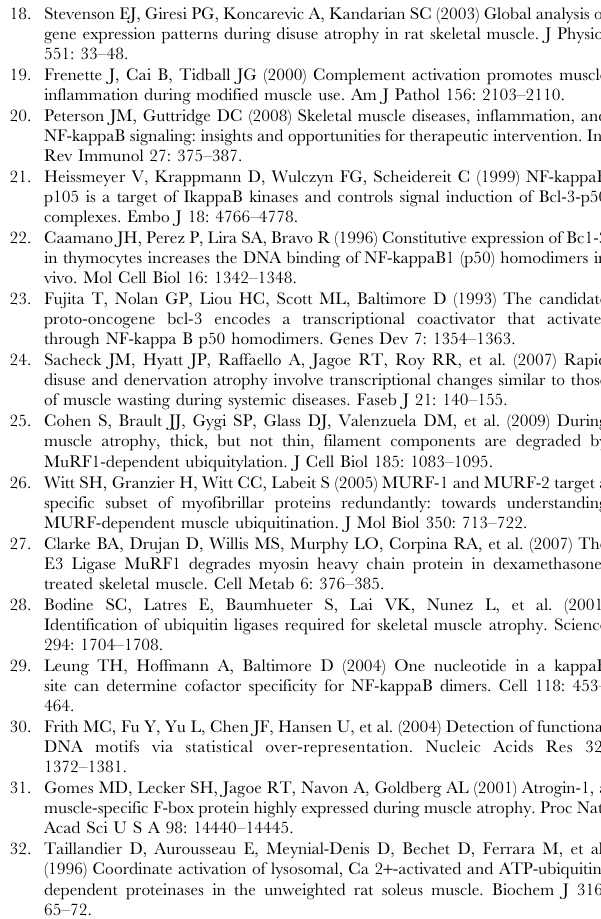
Table S2 Complete list of atrophy genes that are target genes for